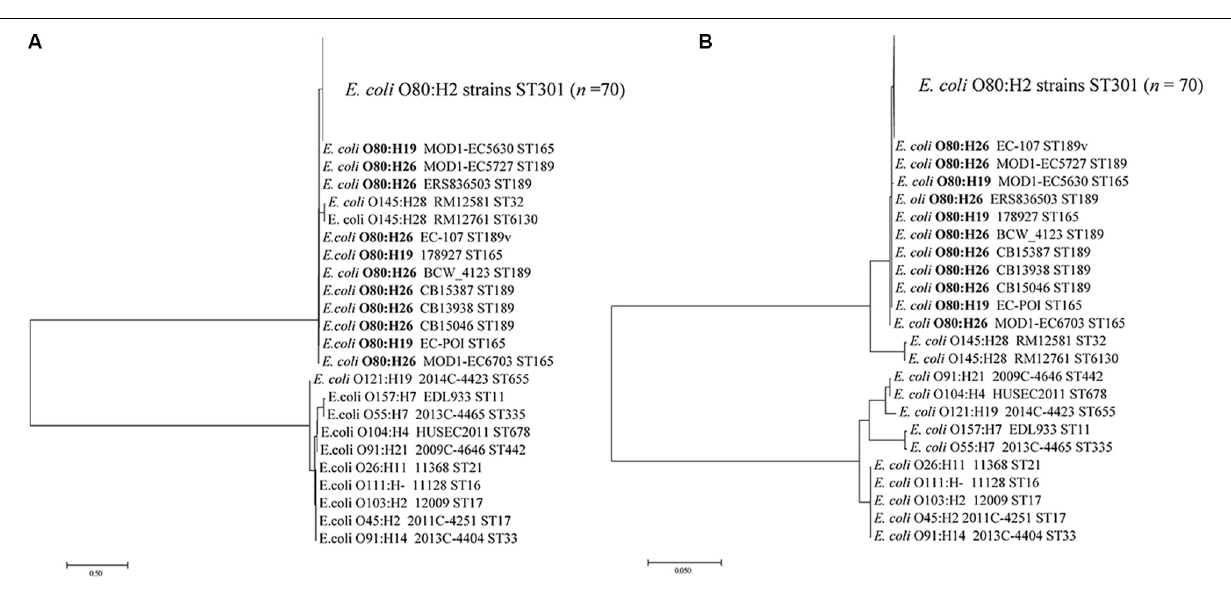
FIGURE 4 | Phylogenetic analysis of STEC O80 strains based on cas1 gene as well as 12 reference STEC strains. The sequences of cas1 gene from STEC O80 strains and 12 reference STEC strains are concatenated to construct a neighbor-joining tree (A) and maximum likelihood tree (B)